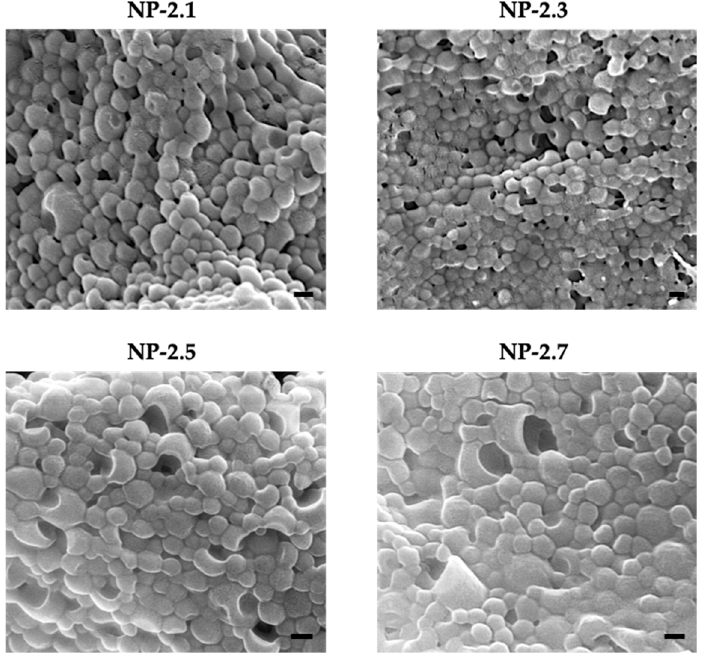
Figure 5. Representative SEM images of S14-loaded PLGA nanoparticles prepared by nanoprecipi- tation methodology. Scale bars: 100 nm.